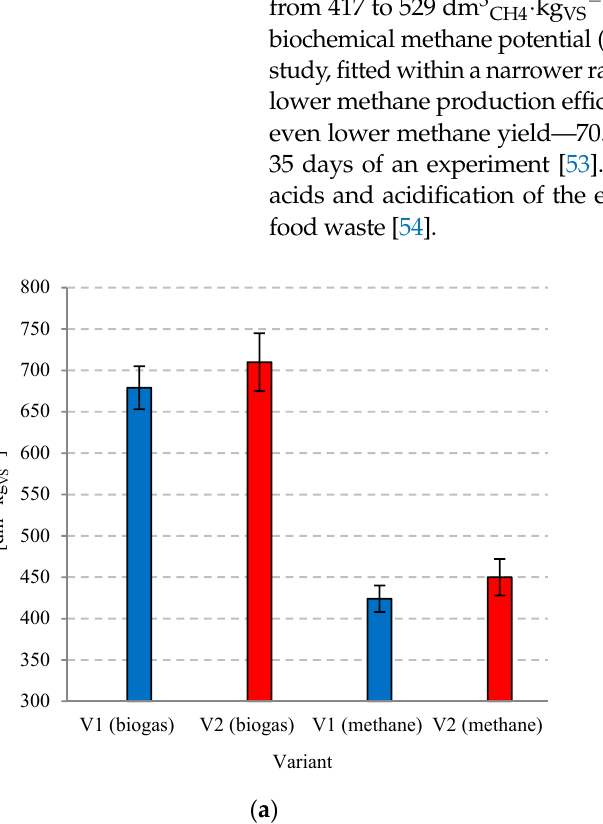
Figure 2. Average daily production of gaseous methane fermentation (MF) products ( a ) and the methane fraction in the biogas ( b ).